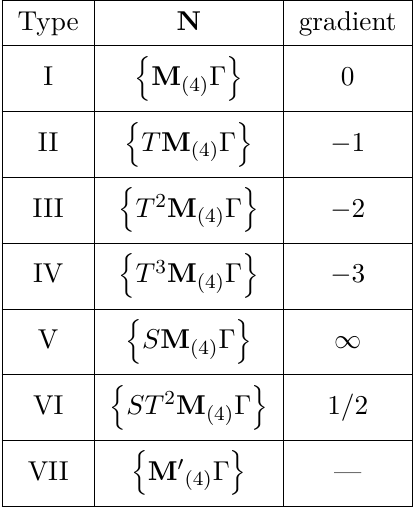
Table 10 . Types for D = 4